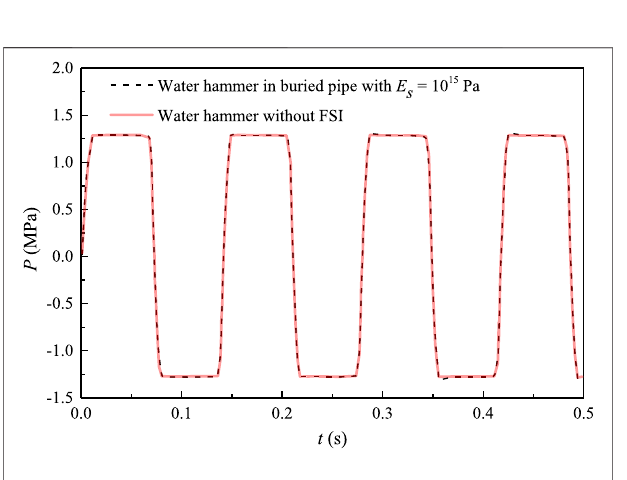
FIGURE 6 | Dynamic pressure with and without FSI. FIGURE 7 | Hydraulic pressure by different